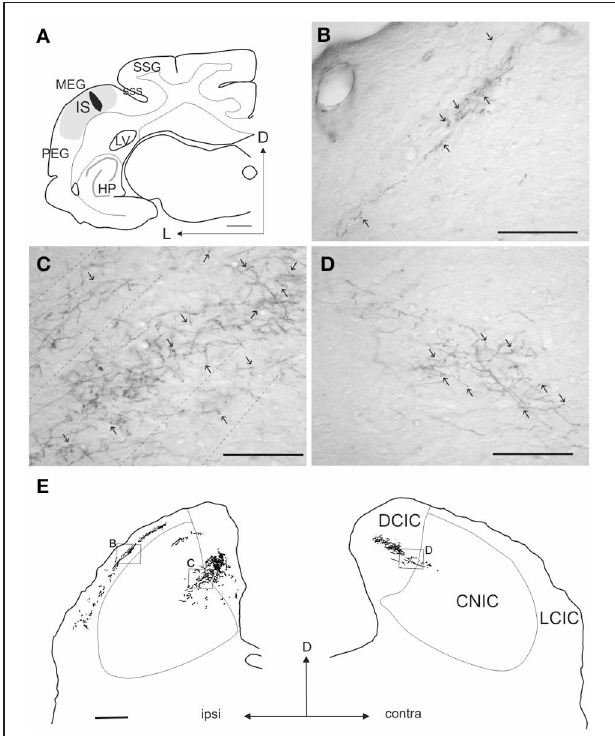
FIGURE 4 | Terminal fields in the IC after a tracer injection in the ferret auditory cortex. (A) Coronal section at the level of the left auditory cortex showing the location of a rhodamine injection site in the center of the MEG where A1 is located. The halo of the injection site is shown in gray while the center is in black. (B–D) Examples of anterograde terminal fields in the IC at the locations indicated by the boxes in (E) . Calibration bars: 1mm (A) , 100 µ m (B–D) , 0.5mm (E) . Modified with permission from Bajo et al. (2007).